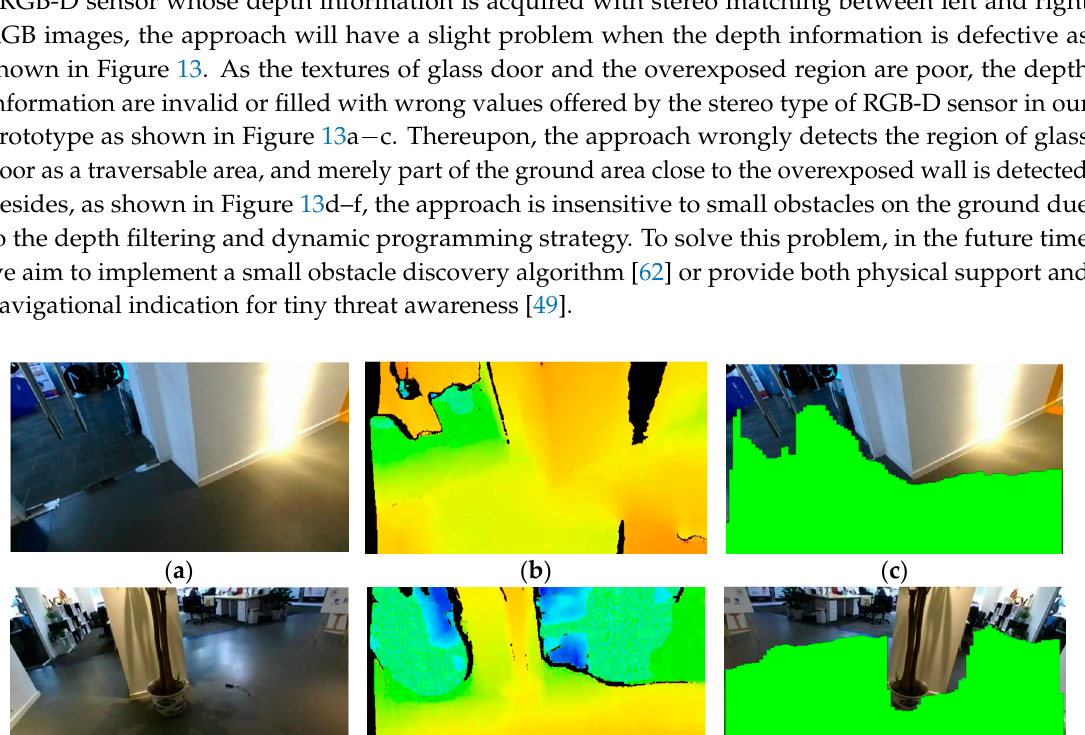
( c ) Figure 14. ( a , b ) The voluntary participants wearing the assisting prototype including a pRGB-D sensor, a laptop in the backpack and a set of bone-conduction headphone; ( c ) The route around a building and an empty field in the real-world environment while the red labels represent the locations during navigation. After the learning and familiarization stage, ten voluntary participants were blindfolded and were required to travel around a building and an empty field without colliding into obstacles or stepping into water areas. As a comparison task, the ten volunteers were divided into two groups randomly and while one group travelled with only traversable area detection, the other group travelled with both traversable area and water hazard detection. To provide the participants with a sense of orientation, the user would get an extra hint to turn at the bends or the road intersections. For a single test, three measures were recorded including the time needed by a participant to walk the route as shown in Figure 14c, the number of collisions into obstacles and the number of times they stepped into water areas. The route was acquired through recording the real-time locations